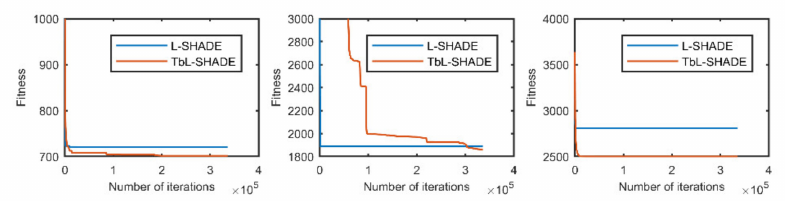
Figure 8. The selected average convergence of L-SHADE and TbL-SHADE is compared on CEC2020 in 20 D . From left to right f3, f5 and f9.